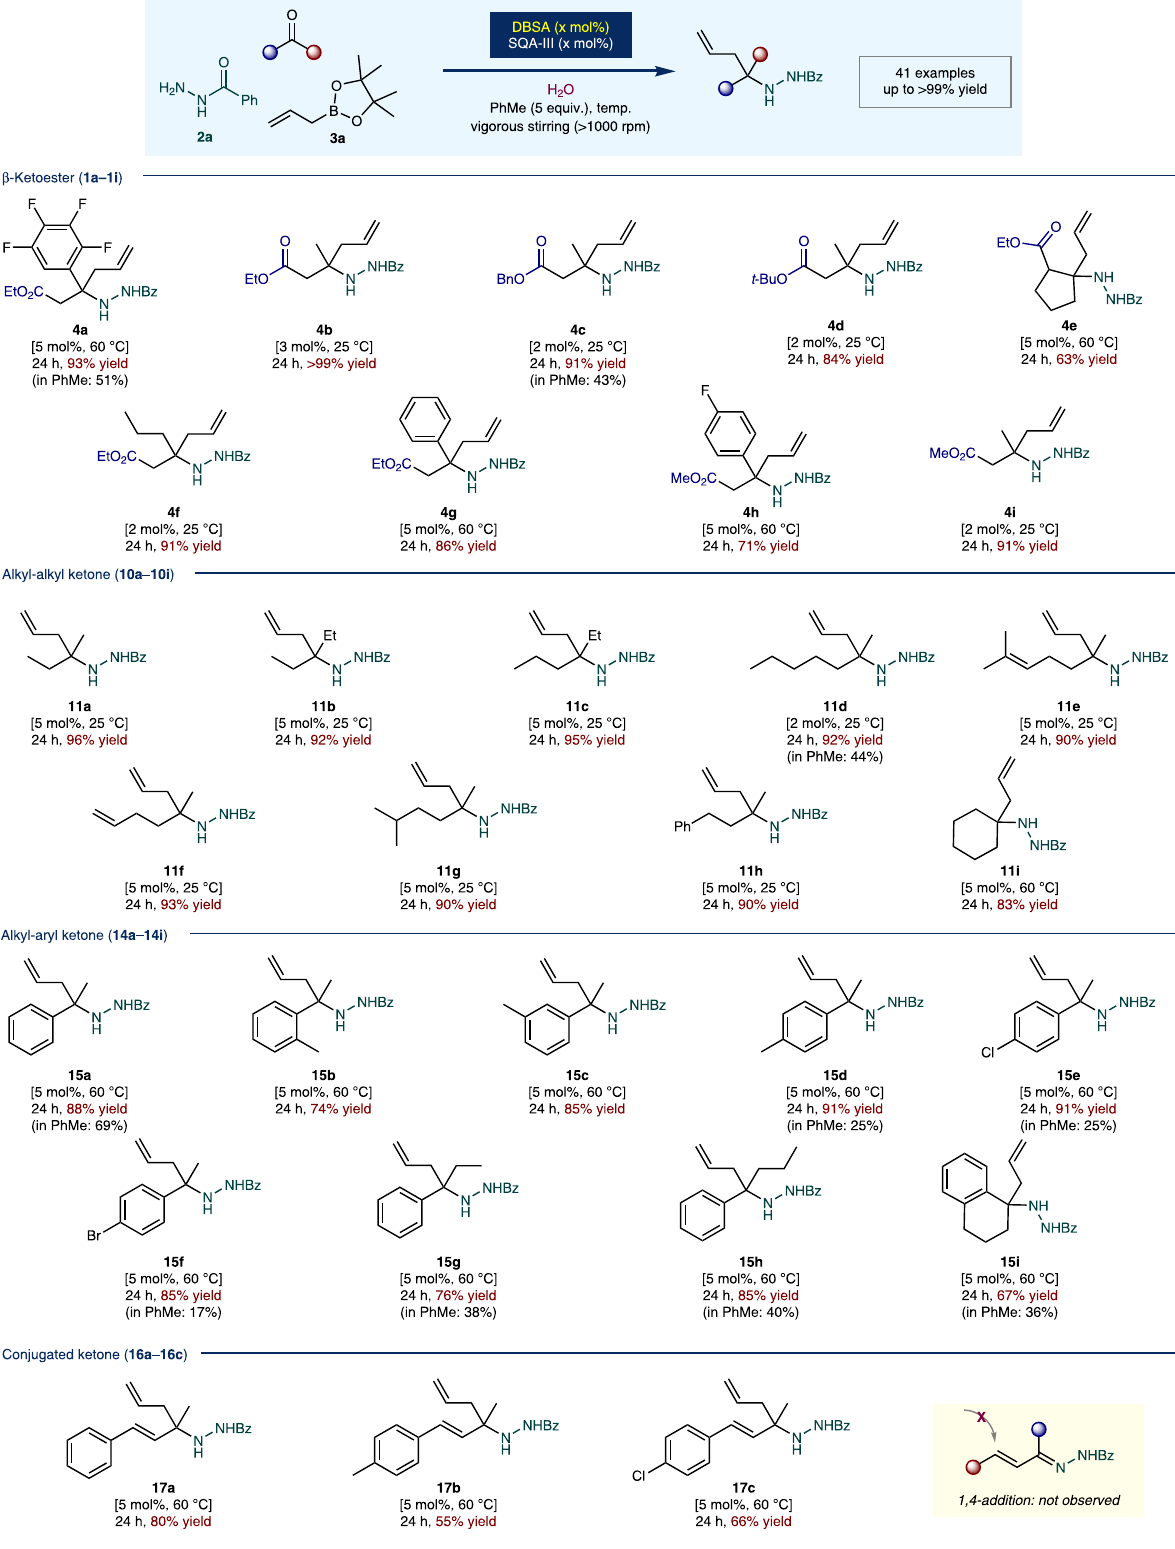
Fig. 4 Substrate scope of allylation reaction (continued on Fig. 5). a β -Ketoester. b Alkyl-alkyl ketone. c Alkyl-aryl ketone. d Conjugated ketone. a Conditions: Reactions were performed with ketone (0.2 mmol), benzhydrazide 2a (1.2 equiv.), allylboronic acid pinacol ester 3a (1.5 equiv.), and a set of catalysts (2.0 – 5.0 mol%) with water (2.0 mL: 10 L/mol (ketone)) and PhMe (5.0 equiv.) at 25 – 60 °C for 24 h. b Yields were determined after chromatographic puri fi cation. Bn = benzyl; t -Bu = tert -butyl; Bz = benzoyl; Et = ethyl; Me = methyl; Ph =